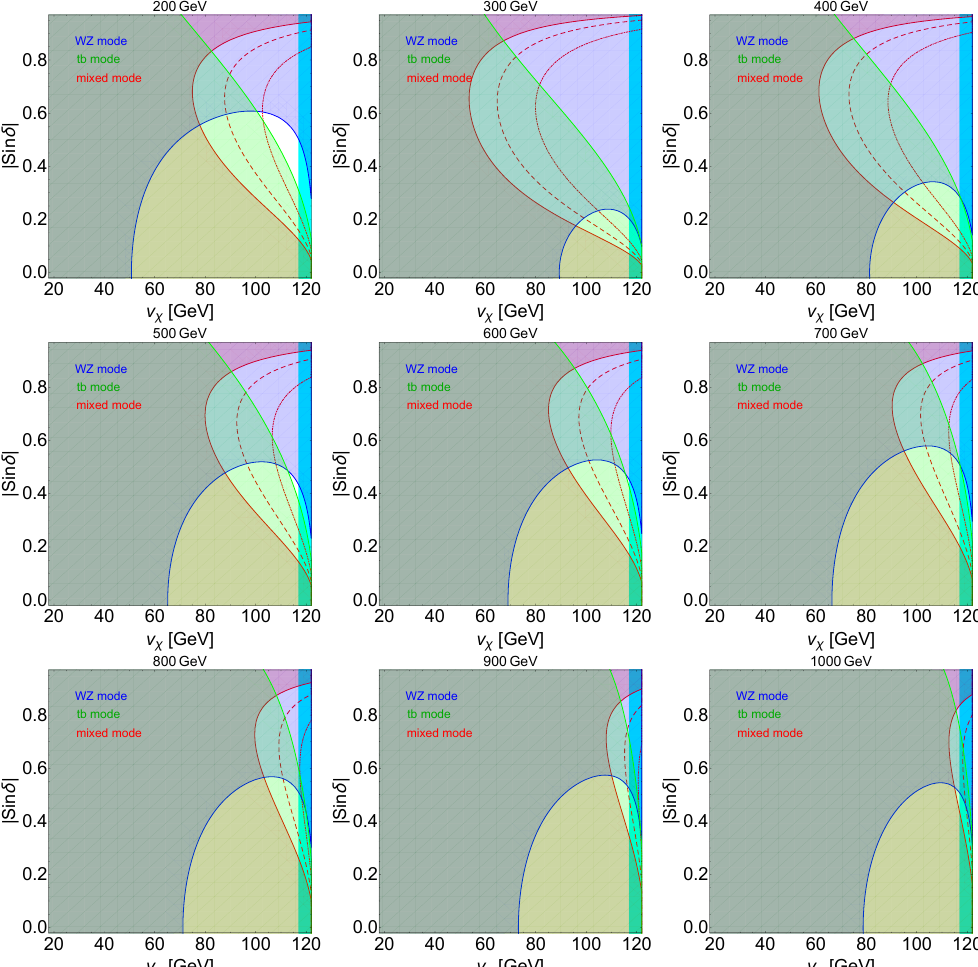
Figure 7 . Sensitivities to v (cid:31) and j sin (cid:14) j in the MGM model with H (cid:6) = H m (cid:6) 1000 GeV with the minimal total width assumption. The blue and green regions are obtained from the exclusion limit at 95% C.L. of the processes pp ! tH (cid:6) , H (cid:6) ! tb and pp ! jjH (cid:6) , H (cid:6) ! W (cid:6) Z , respectively. The red solid, dashed and dot-dashed curves correspond to the exclusion limit at 95% C.L. and discovery prospects with Z D = 3 ; 5, respectively. The cyan vertical regions on the right of the panels are excluded by the perturbative unitarity